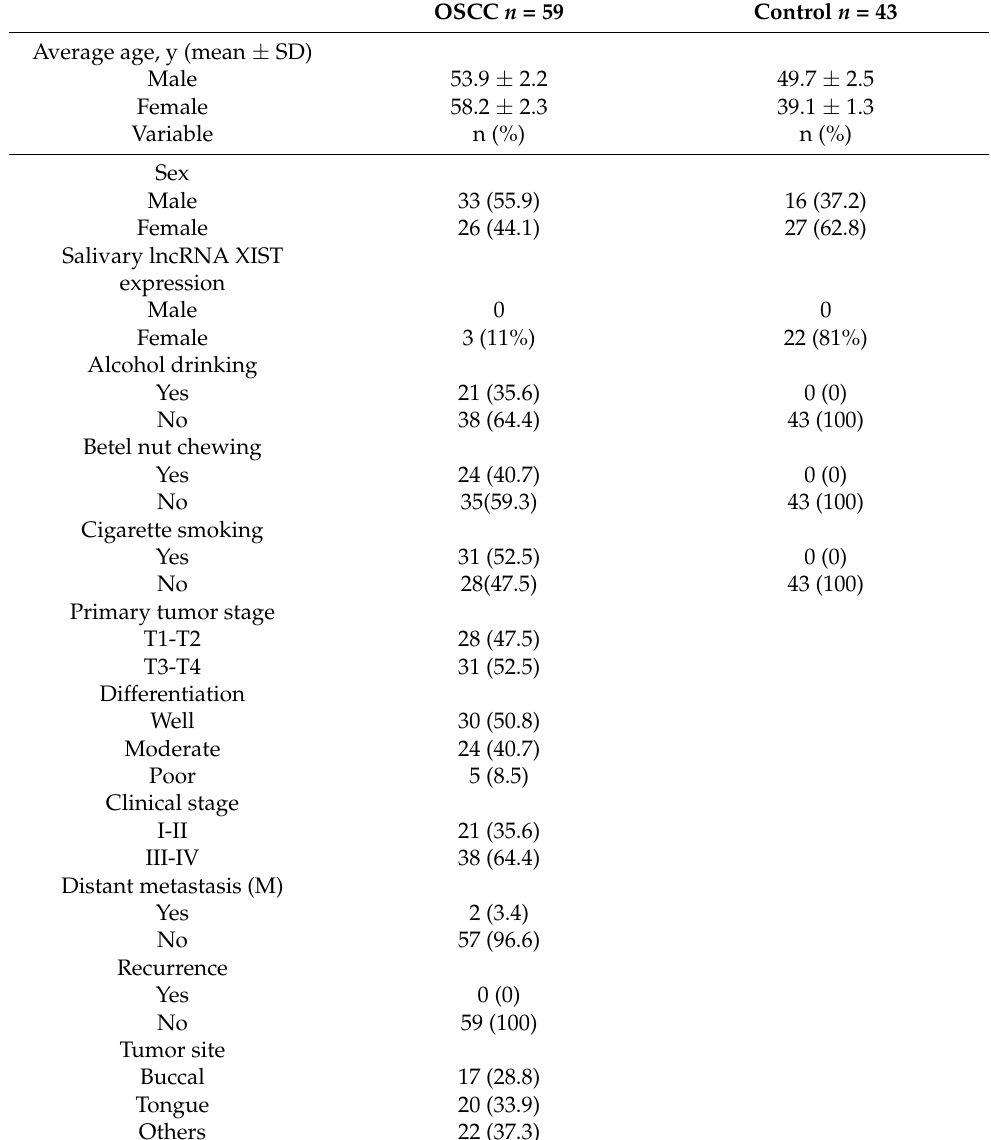
Table 1. Characteristics of 102